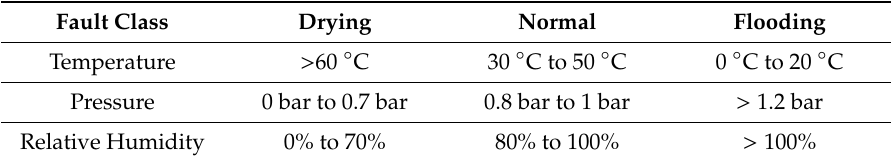
Table 2. Fuel cell operation range to simulate various